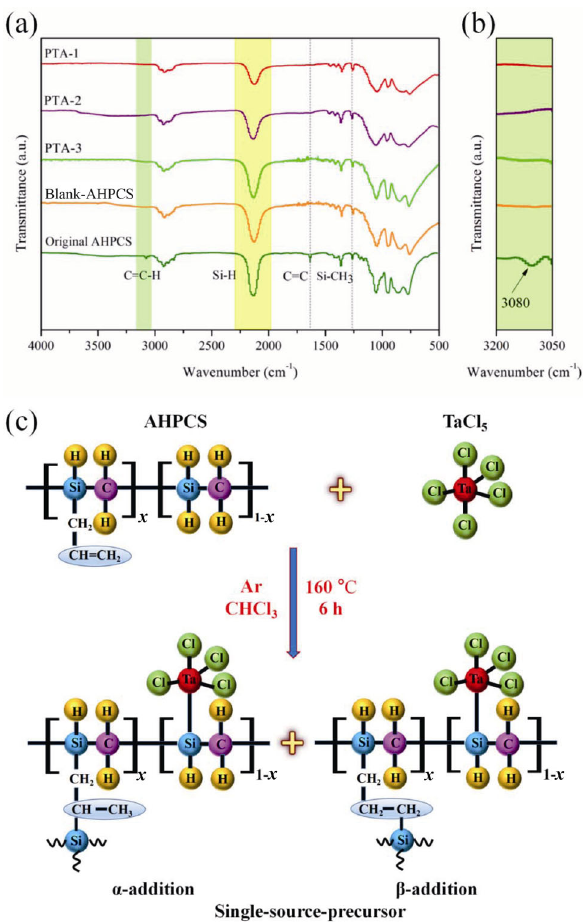
Fig. 2 (a) FTIR spectra of original AHPCS, blank- AHPCS, and single-source-precursors and (b) the region from 3050 to 3200 cm –1 is shown magnified. (c) Reaction pathways during the precursor synthesis.